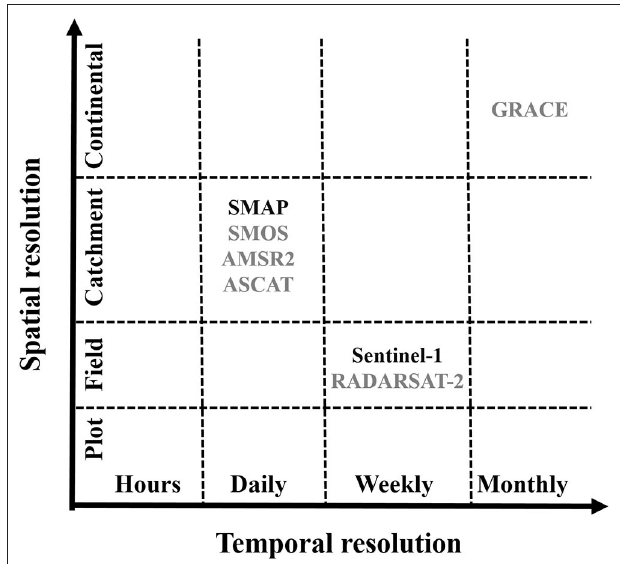
FIGURE 10 | Spatial and temporal resolutions of current remote sensing soil moisture monitoring satellites. Satellites used in this study are highlighted in black and other satellites designed to monitor soil moisture are marked in